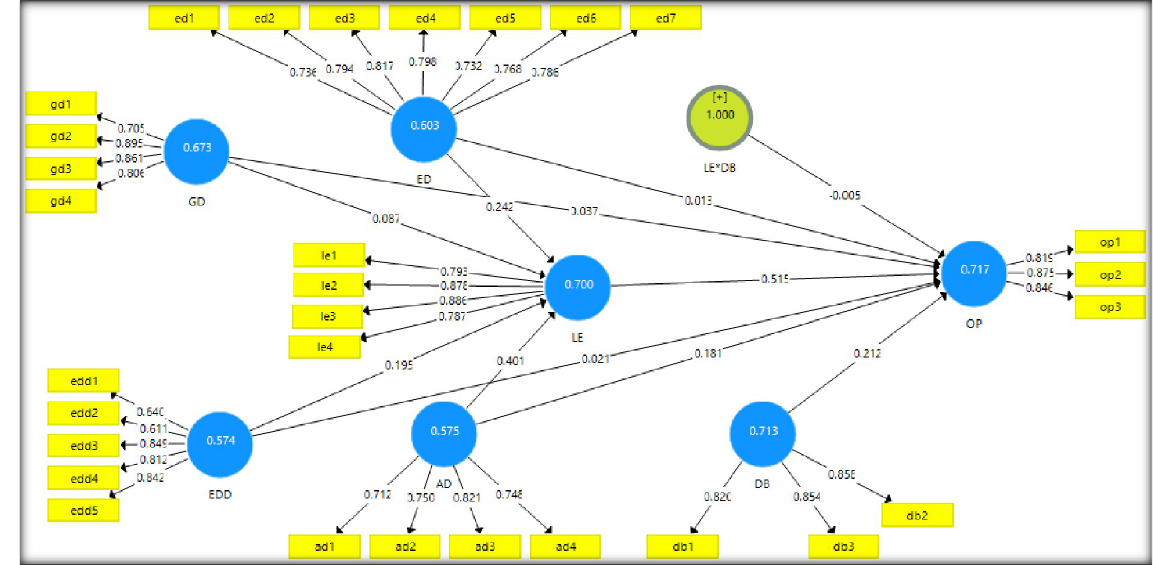
Fig 2. PLS-Algorithm result with outer loadings and